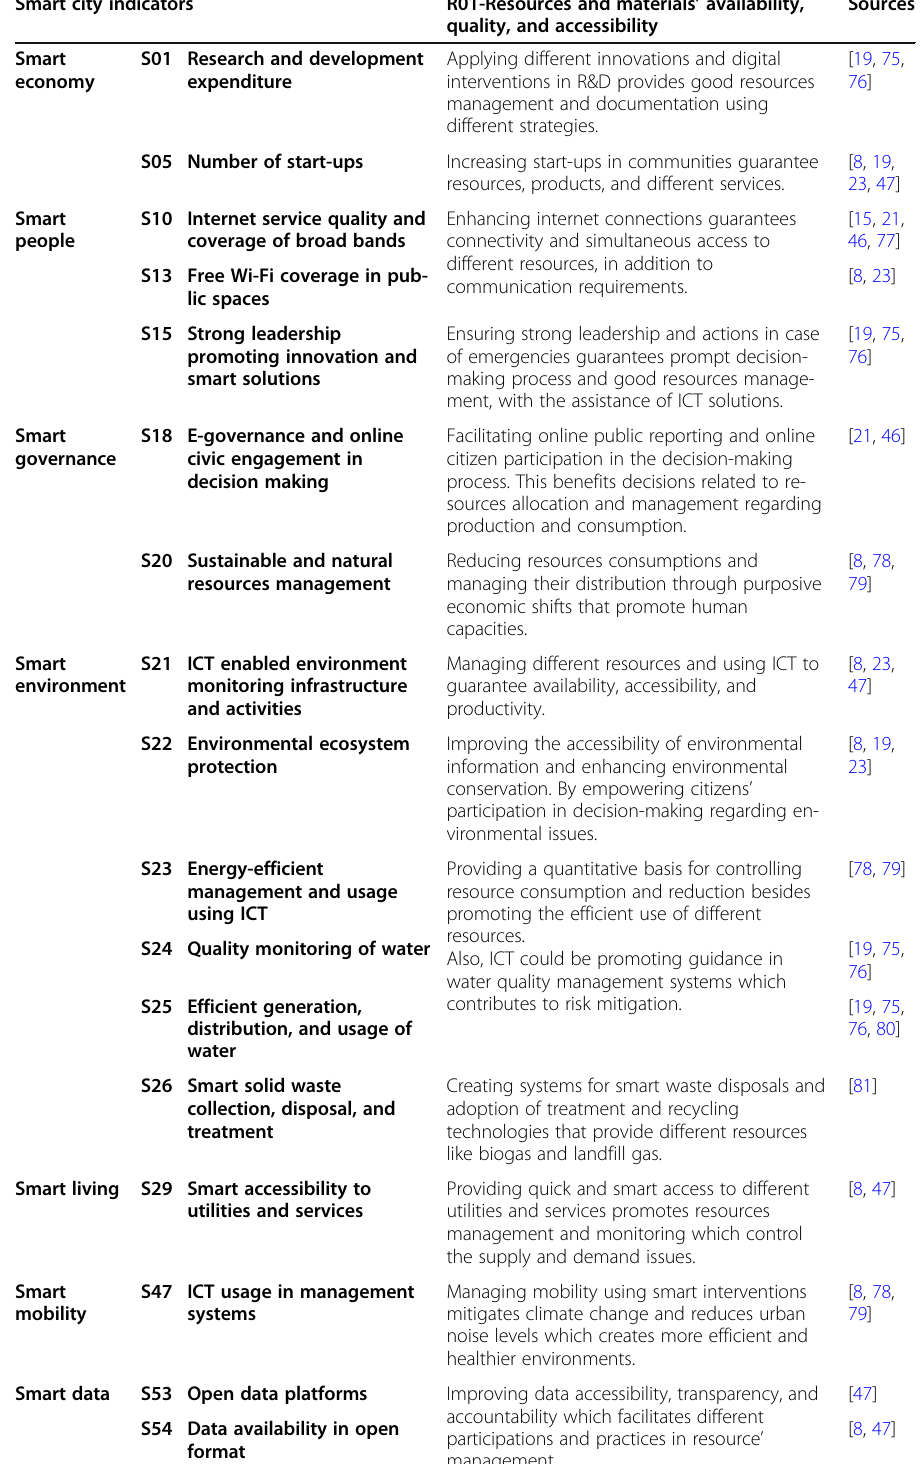
Table 4 Illustration for smart city indicators and R01 principle or urban resilience Smart city